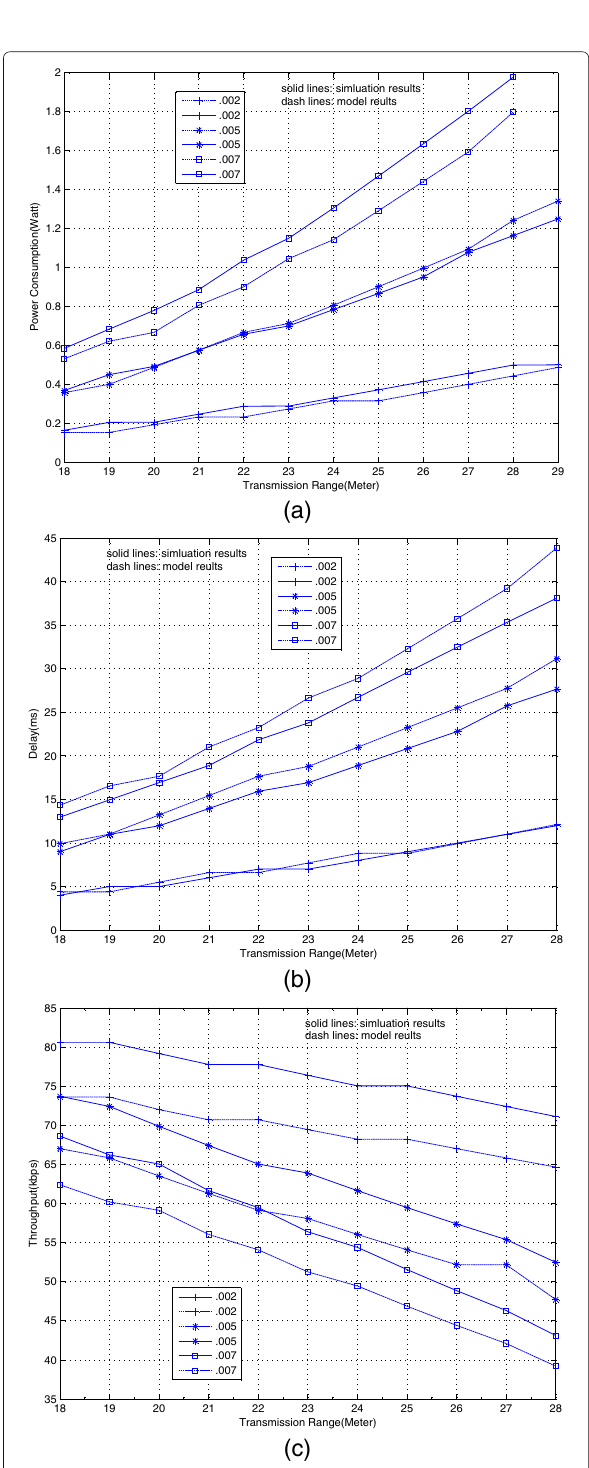
Fig. 9 X-MAC performance with varying transmission range. a Power consumption, ( b ) Delay, ( c )